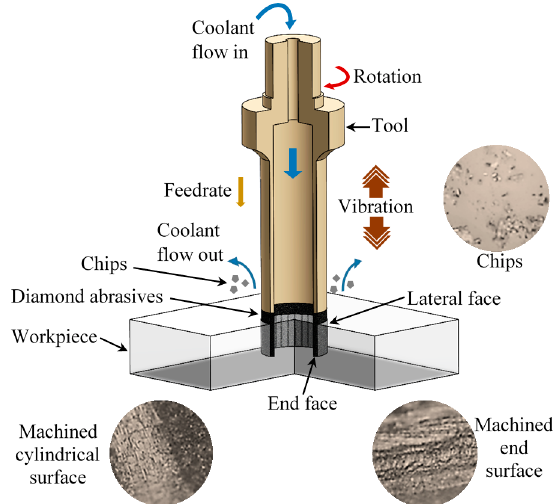
Figure 1. Illustrations of Rotary ultrasonic machining (RUM) and microscopic pictures of machined surface, cutting interface, and cutting chips of K9 glass.